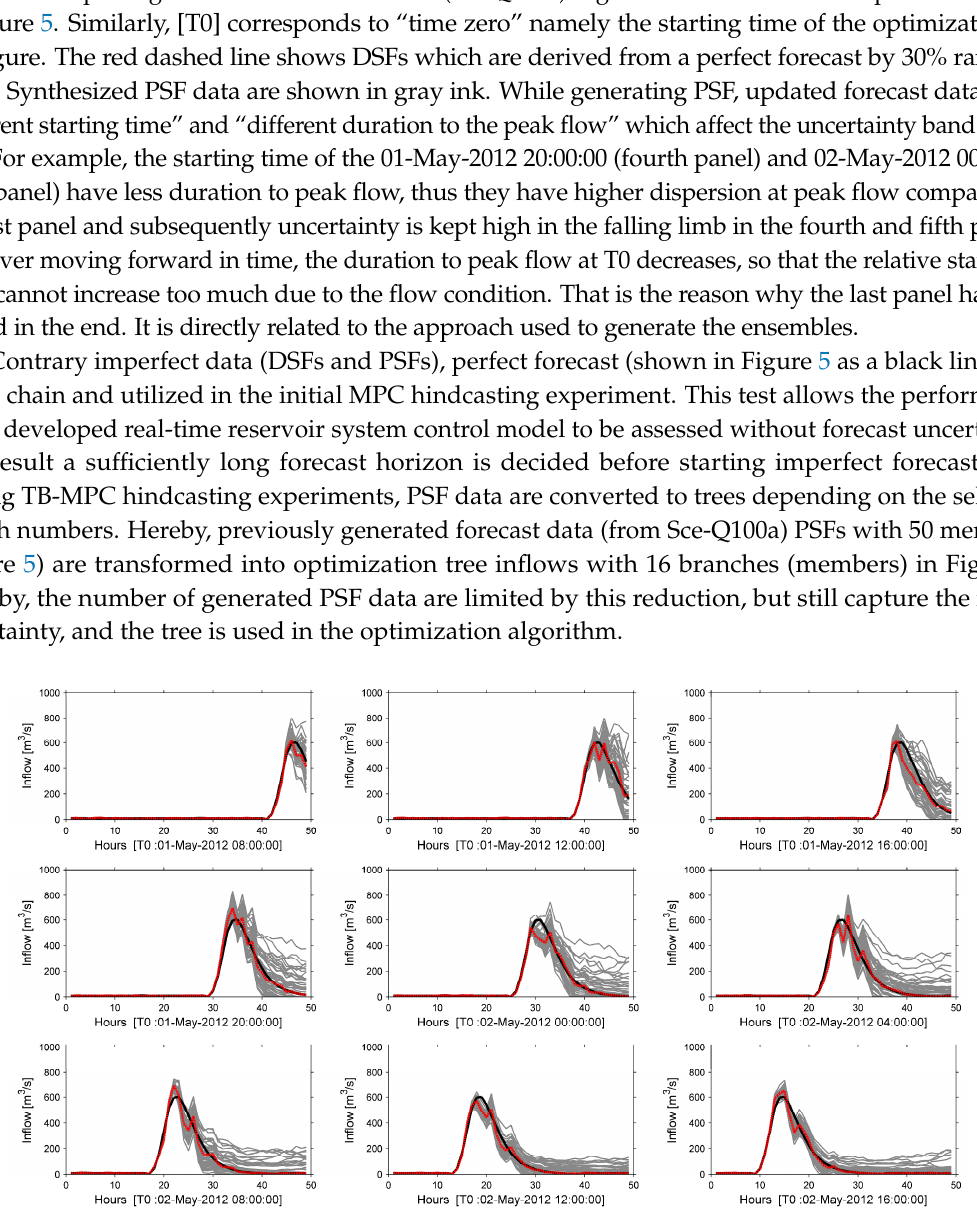
Figure 5. Perfect forecast, DSF vs. PSF for different receding horizons (Sce-Q100a).